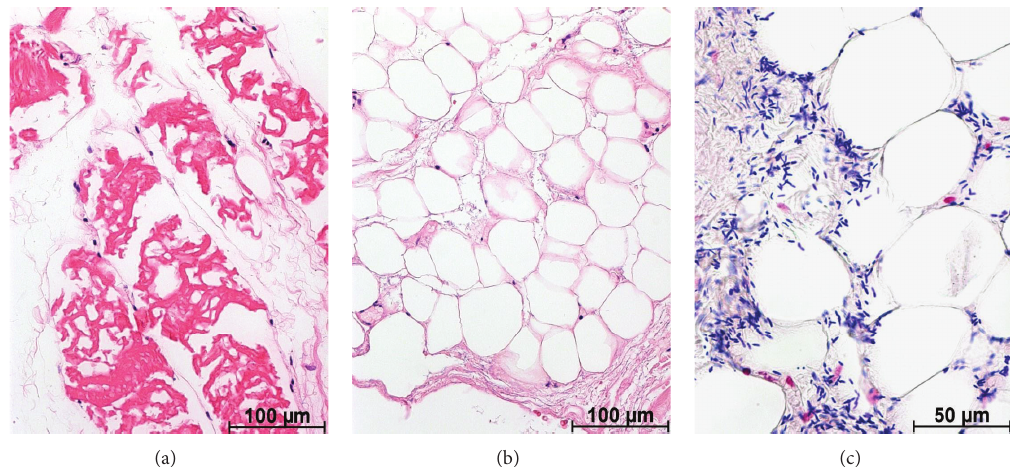
Figure 2: Histopathological findings. (a) Muscle fibers showed irregular condensation of sarcoplasm with no stainable nuclei of muscle cells. Several fibroblasts were apparent between the necrotic muscle fibers (stain: hematoxylin-eosin, original magnification: × 200). (b) Adipocytes and fibrous tissue displayed edema and only few stainable nuclei, consistent with soft tissue necrosis (hematoxylin-eosin: × 200). (c) Between the necrotic cells, numerous large, blunt-ended rods were apparent, consistent with Clostridium bacteria (Gram stain: × 400).